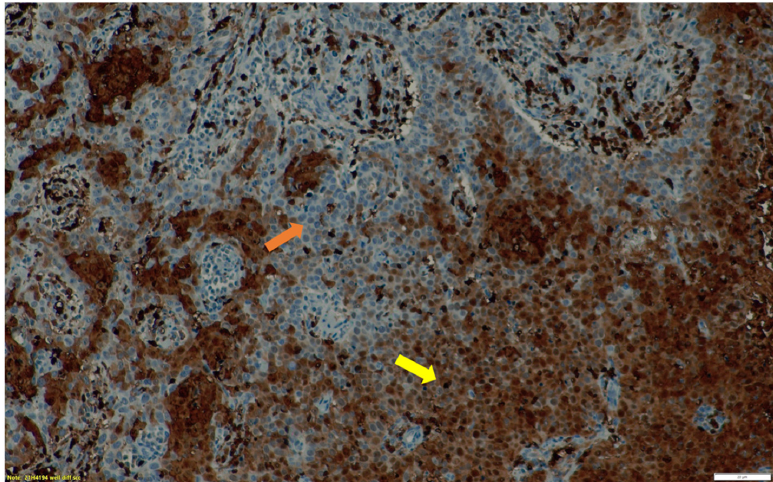
Figure 3. The immunohistochemical staining of HIF-1 α expression in the endocervical biopsy specimen of the patient in Figure 2. Well differentiated squamous cell carcinoma ×20 magnification. The tumor areas with well differentiated cells ( yellow arrow ) with brown staining, demonstrate HIF-1 α expression, while the areas with other cell types ( orange arrow) demonstrate little to no HIF-1 α expression. Table 3. SUVmax and TMR from the 18 F-FDG and 68 Ga-Nitroimidazole PET/CT scans correlated with the HIF-1 α